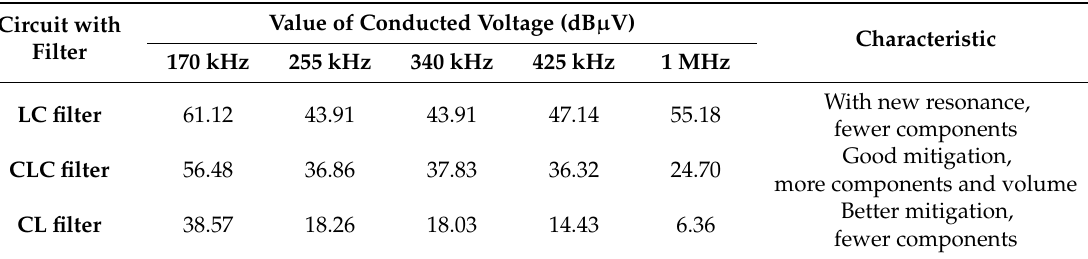
Table 4. The value of conducted voltage in three circuits of